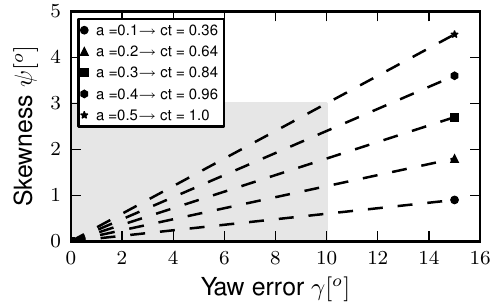
Figure B1. Representation of the effect of wind turbine misalign- ment ( γ ) on wake skewness ( ψ